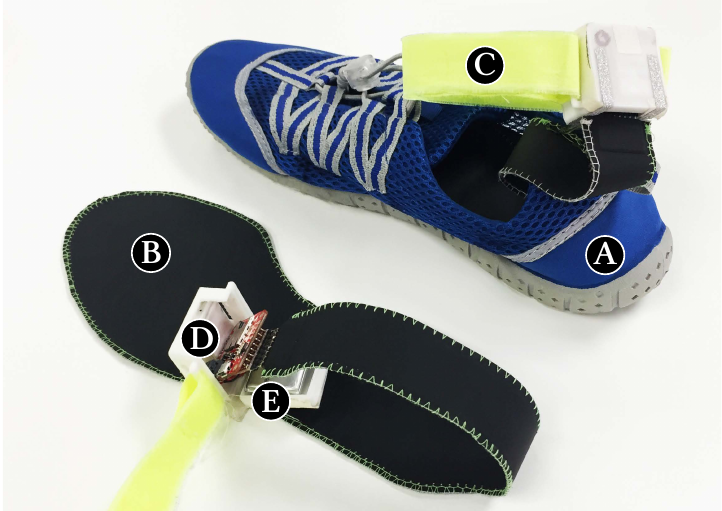
Figure 1. Prototype: ( A ) shoe, ( B ) sensing.tex insole, ( C ) ankle strip, ( D ) SAMD21 microprocessor board with inertial measurement unit (IMU), secure digital (SD) card, voltage divider circuit and ( E ) 400 mAh